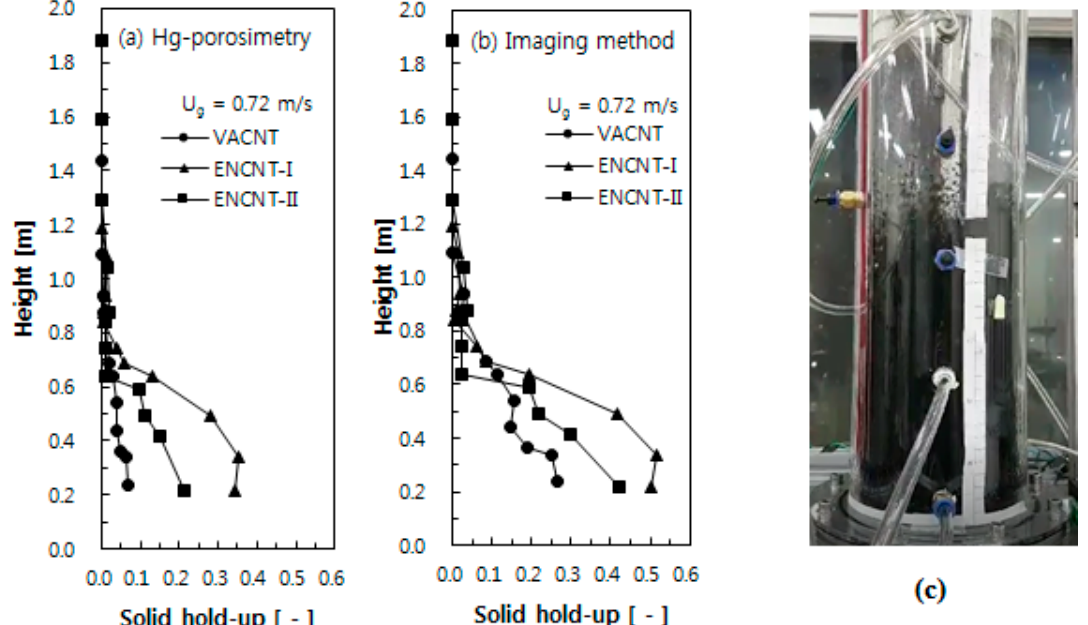
Figure 11. Axial holdup distributions by ( a ) Hg-porosimetry and ( b ) imaging method; ( c ) photograph of of upper part of VACNT fluidized bed at U g = 0.72 m/s.